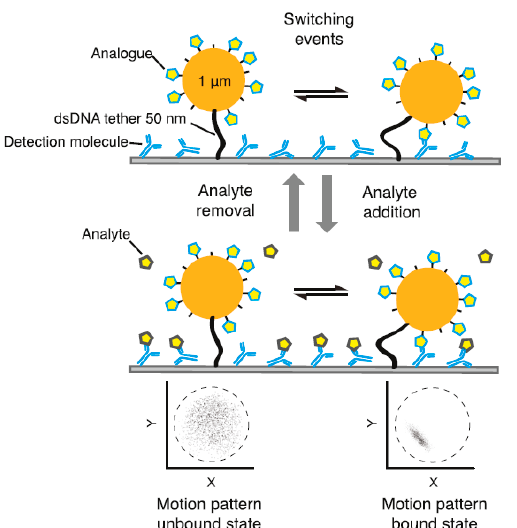
Figure 8. Particle motion on the substrate. Microparticles are tethered on the substrate using DNA duplex. When analogues immobilized on the microparticle interact with the detection molecule on the substrate, particle motion is restricted. In the presence of the analyte, the motion of the micro- particle is no longer restricted because the detection molecules are blocked by the analytes. Repro- duced from Ref. [92] with permission. © 2020. This work is licensed under a CC BY 4.0 license. The translational and rotational diffusion of the particle can be evaluated within sev- eral minutes because particle trajectories can be measured by high-speed microscopy.